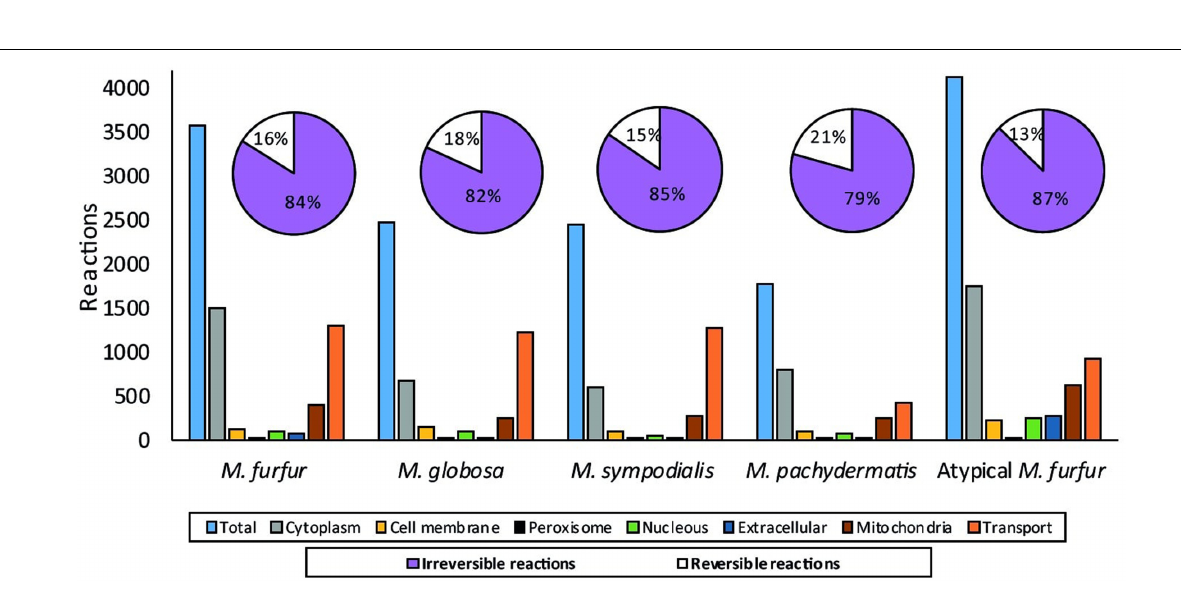
Frontiers in Microbiology |